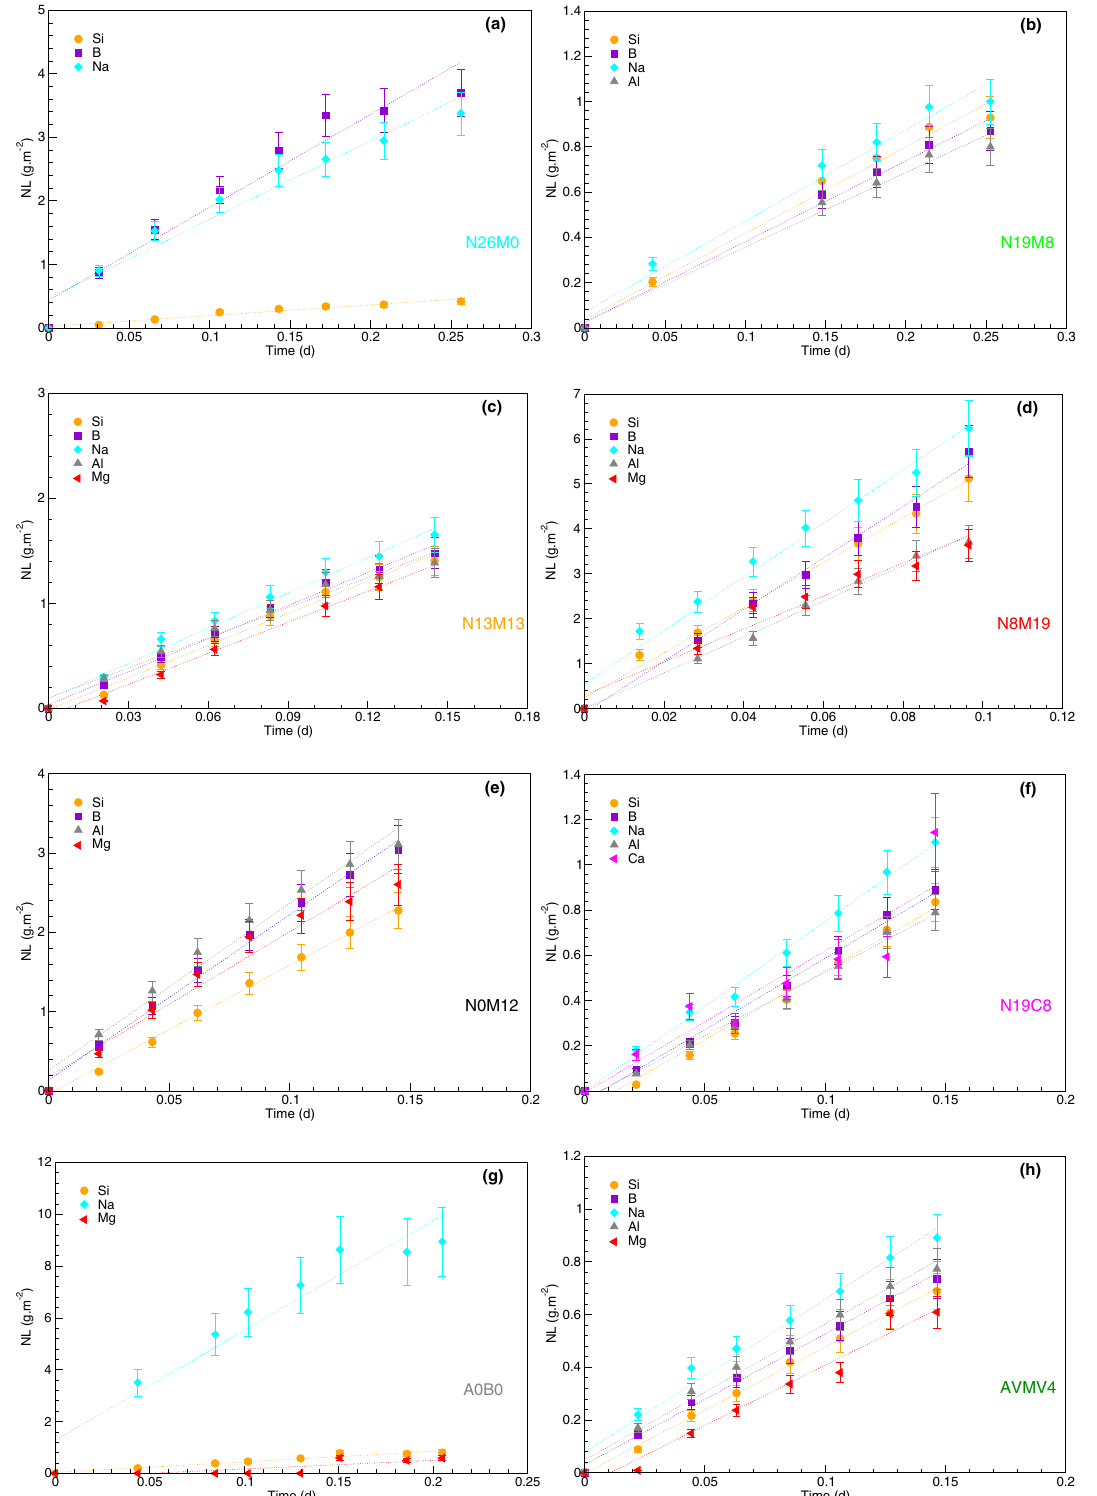
Fig. 2 Evaluation of the congruency of dissolution through ICP-OES-based NL calculation of all elements through time for the different glasses. a N26M0, b N19M8, c N13M13, d N8M19, e N0M12, f N19C8, g A0B0 and h AVMV4. Dashed lines represents the linear regression. Uncertainties on NL based on elemental concentration for a given test are given at ± 15% based on instrumental